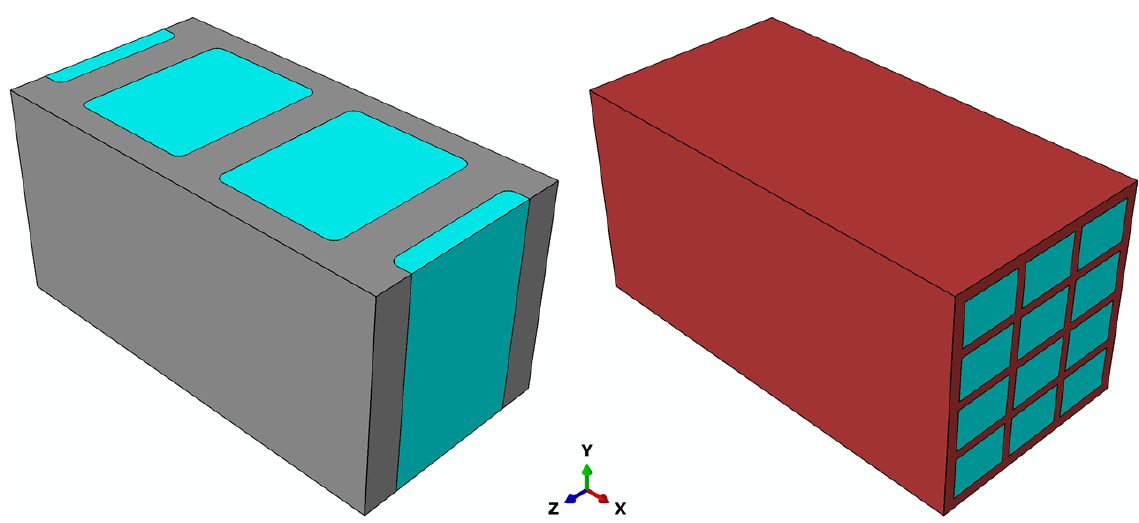
Figure 1. Concrete and red clay brick models.